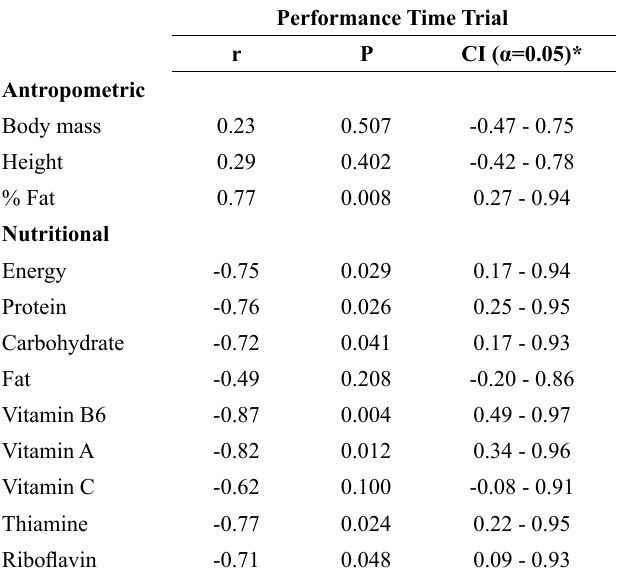
Table 4. Relationship between the anthropometric, nutritional, psy - chological and sleep variables with the performance time